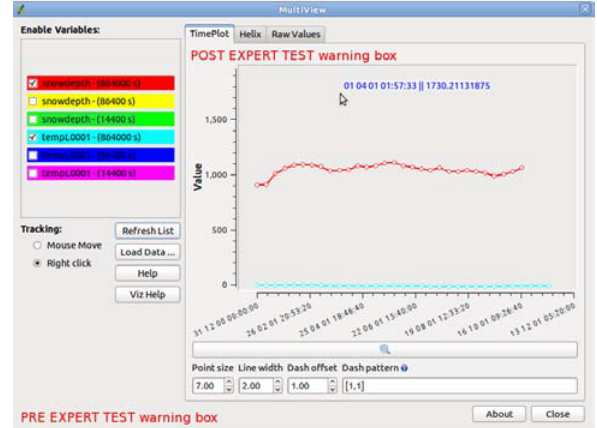
Figure 3. The visualisation framework with the helix view (top- left), scatter plot (bottom-left) and the terrain view (right) 1 Figure 4 The time plot, showing snow depth and temperature 1